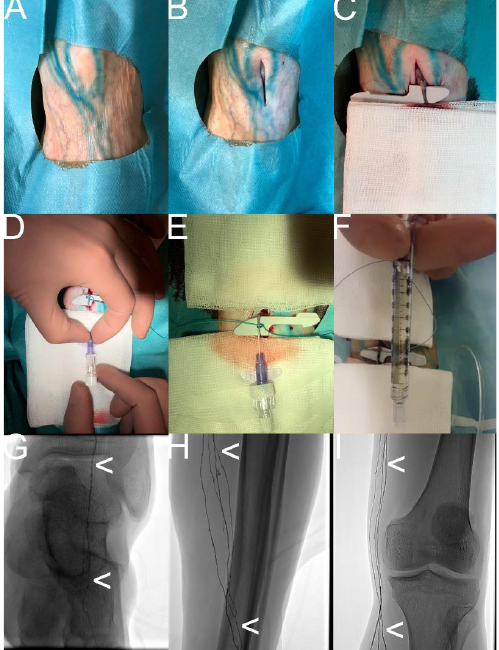
Figure 3. “Transpedal lymphangiography“—How it is performed. Note: ( A ) Patent Blue test; ( B ) sterile, cut-down of the dorsum of the foot; ( C ) selective dissection of a lymph duct; ( D ) selective puncture of the lymph duct with a 25 G baby cannula; ( E , F ) injection of the oil-containing contrast material; ( G , H , I ) confirmation of the regular distribution of the oil-containing contrast material (white arrowhead) in the central lymphatic system (corresponding to a regular lymphatic